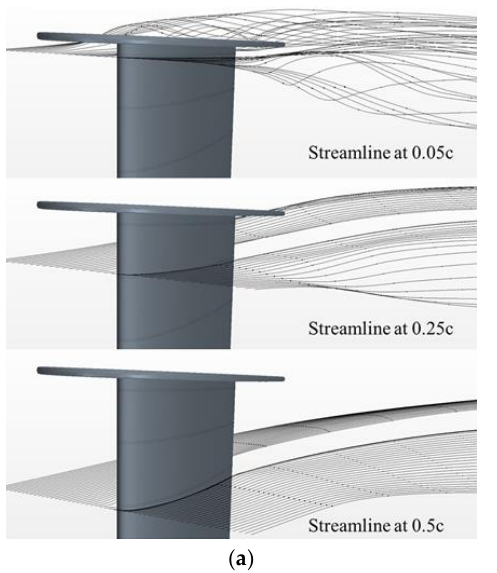
Figure 23. The streamline at different heights of the blade sections when the azimuthal angle is 88 ° : ( a ) with a bulkhead; ( b ) with a top supporting strut-bulkhead structure.